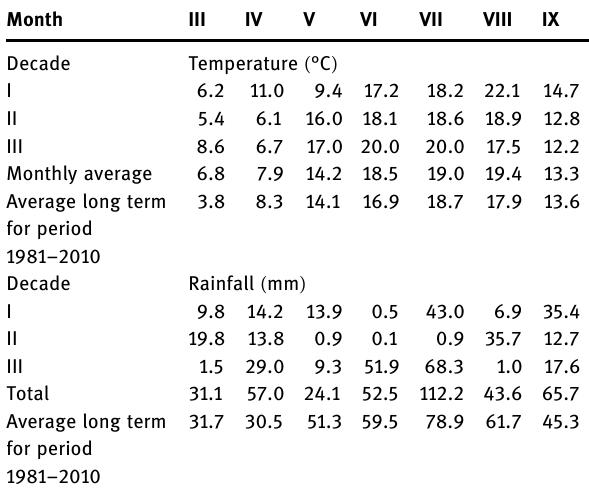
Table 3: Weather conditions ( 2017 ) at Pawlowice experimental fi